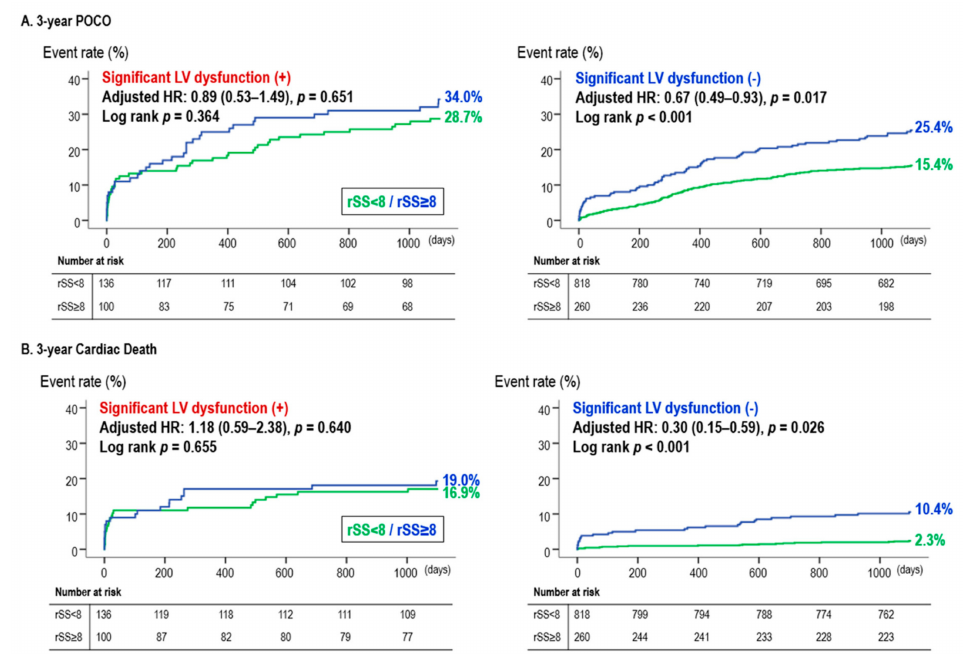
Figure 4. Survival curves during the three-year follow up period, according to the residual SYNTAX score: ( A ) three-year POCO and ( B ) three-year cardiac death. Abbreviations: HR, hazard ratio; LVEF, left ventricular ejection fraction; POCO, patient oriented composite outcome; rSS, residual SYNTAX